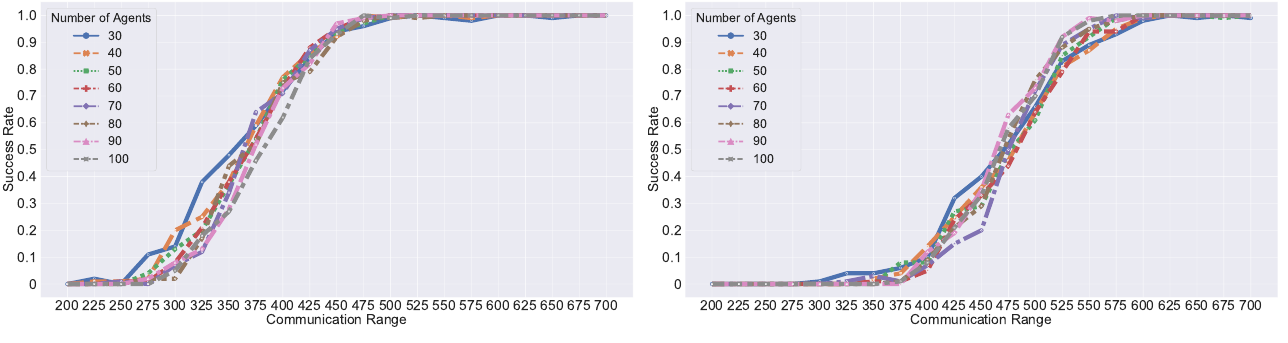
Figure 12. The election success rate within top 10 with half swarm size threshold. ( a ) Our proposed method with respect to different swarm size. ( b ) The Raft-based method with respect to different swarm